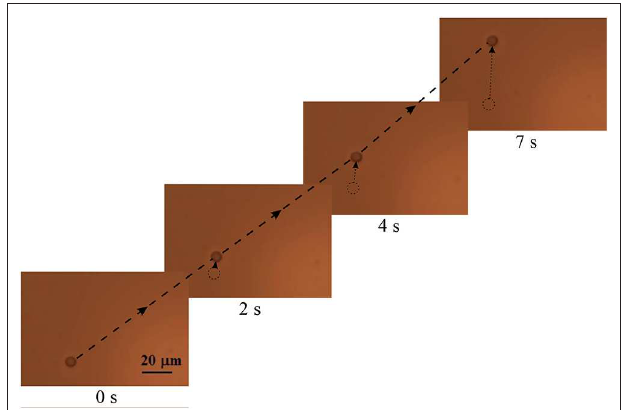
FIGURE 6 | The change in the position of the RBC over time. Single arrows mark the movement of the erythrocyte in the transverse direction. A long dash-dotted line marks the trajectory of the